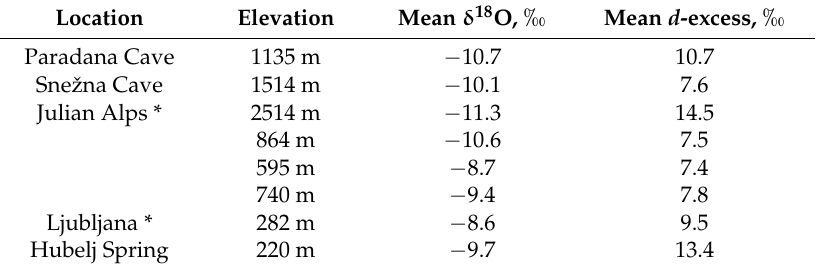
Table 2. δ 18 O and d -excess from our samples and from published